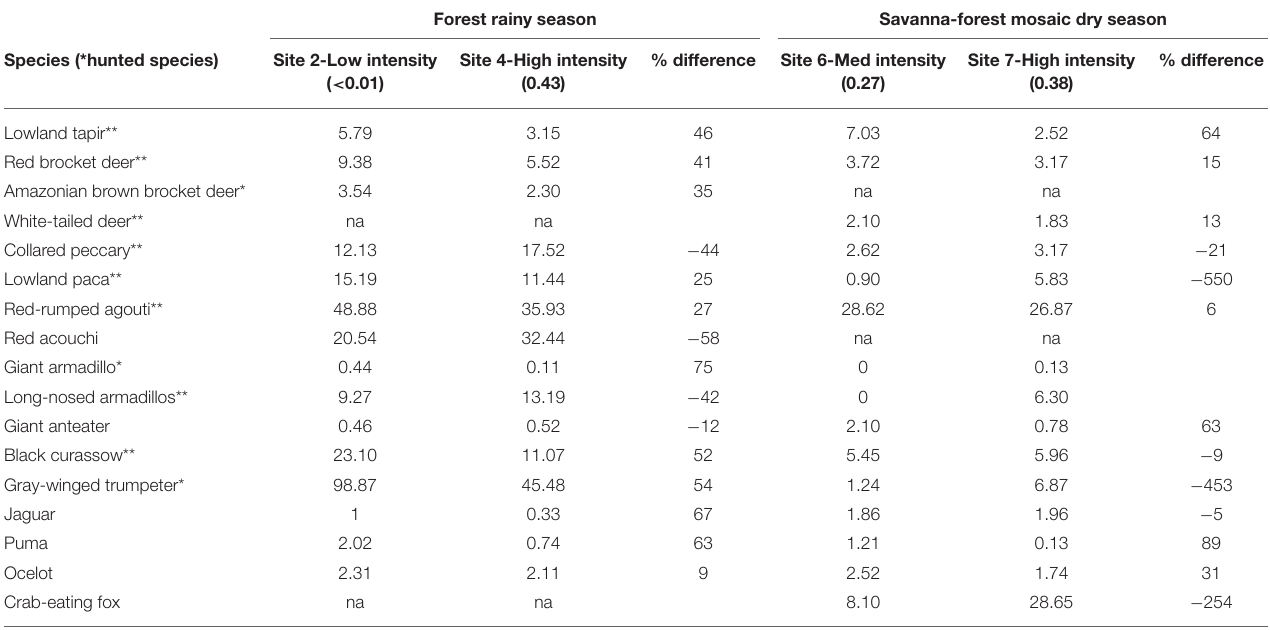
TABLE 4 | Comparison of relative abundance indices (RAI) of species of interest between sites with “low” and “high” hunting intensity, keeping habitat type and season constant. Forest rainy season